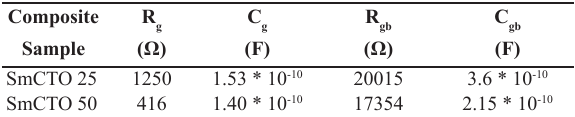
Figure 6. Complex impedance spectrum of Sm CCTO composites. The inset shows the high frequency range of the spectrum. Sr NiO –CCTO composites parameters from im- Table 1. Sm 1.5 0.5 4 pedance